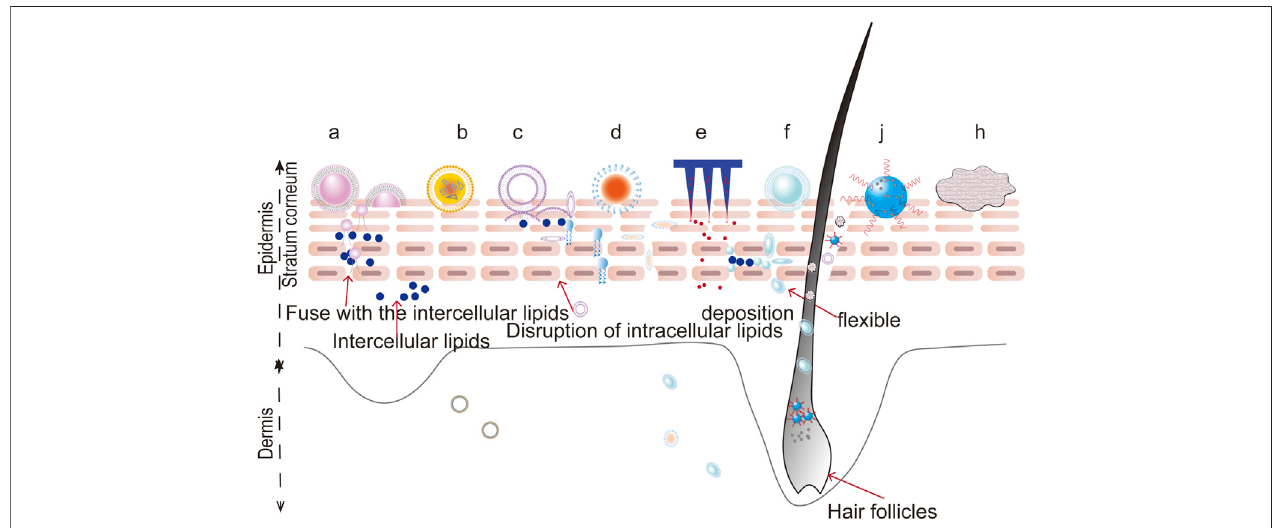
FIGURE 4 | The potential penetration routes of novel drug delivery systems. a: liposomes, b: nanostructured lipid carriers, c: niosomes, d: nanoemulsions, e: microneedles, f: ethosomes, j: nanocrystals, h: foams.